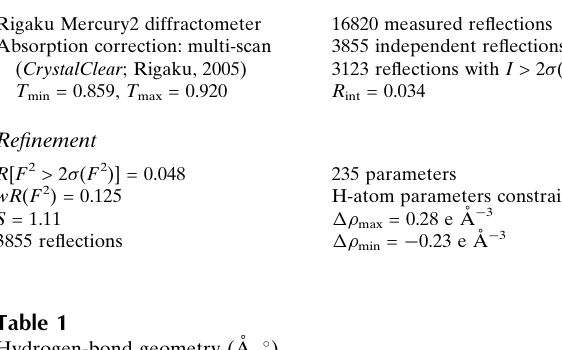
Hydrogen-bond geometry (A˚ , (cid:3)